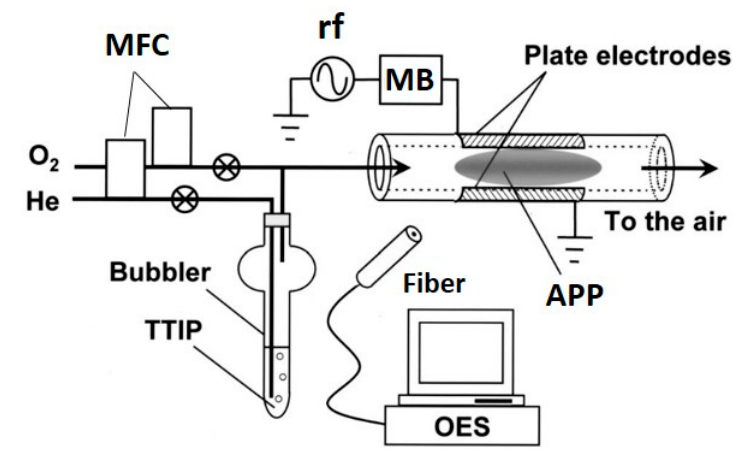
Figure 2. Schematic of the experimental set-up for TiO 2 deposition on the inner surface of a quartz tube using PECVD. Parallel-plate electrodes were attached to the outer surface of the quartz tube. One electrode was connected to an rf (13.56 MHz) generator via a matching box (MB), while the other was grounded. One end of the quartz tube was connected to a gas line that was heated to 40 °C to prevent condensation of TTIP vapor during transfer. The gas flow to the tube was adjusted by mass flow controllers (MFCs). The other end of the quartz tube was open to the air; thus, in this experiment, APP, specifically microplasma, was generated. Light emitted from the APP was collected by an optical fiber and monitored by optical emission spectroscopy (OES). Reprinted with permission from Ref.